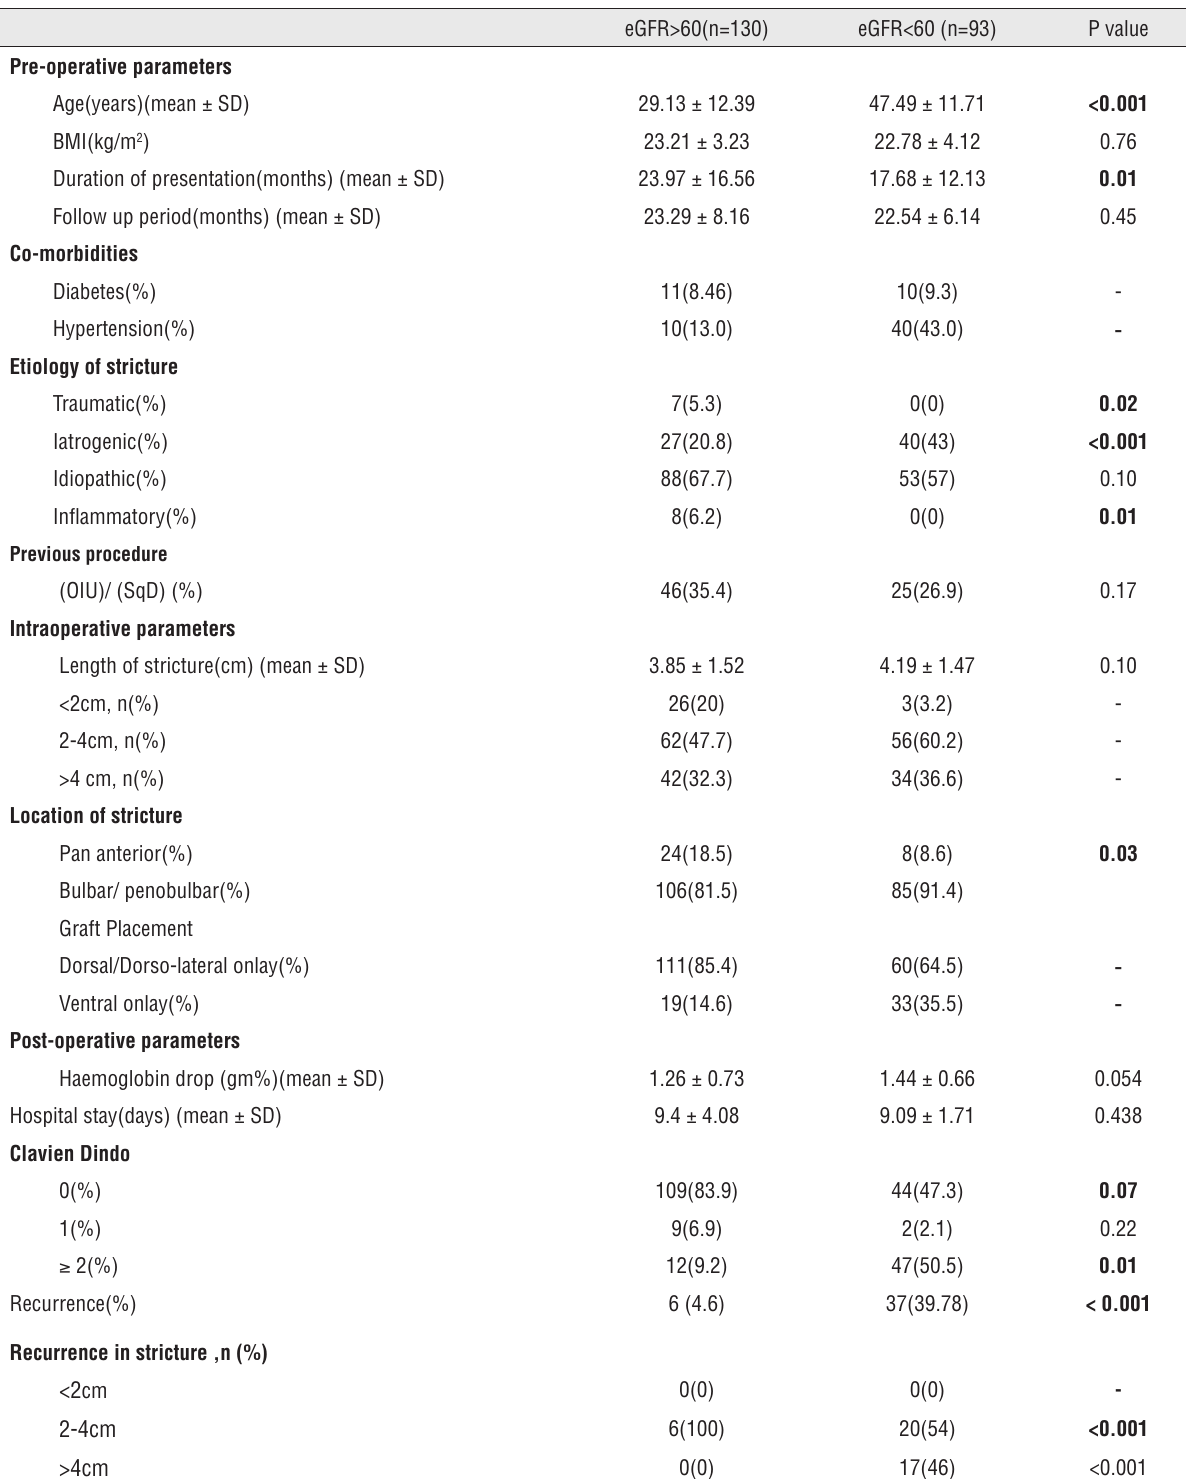
Table 1 - Patient characteristics and demographic